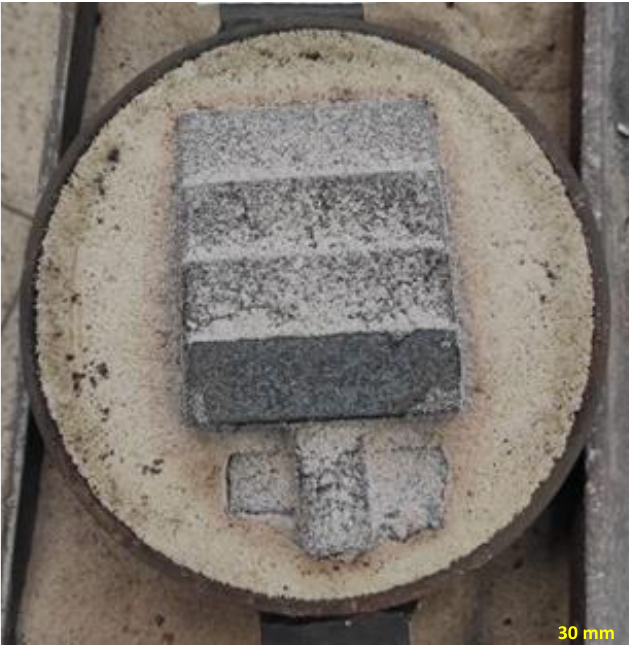
Figure 12. Open form after cooling, made of a mass containing 2% MB.